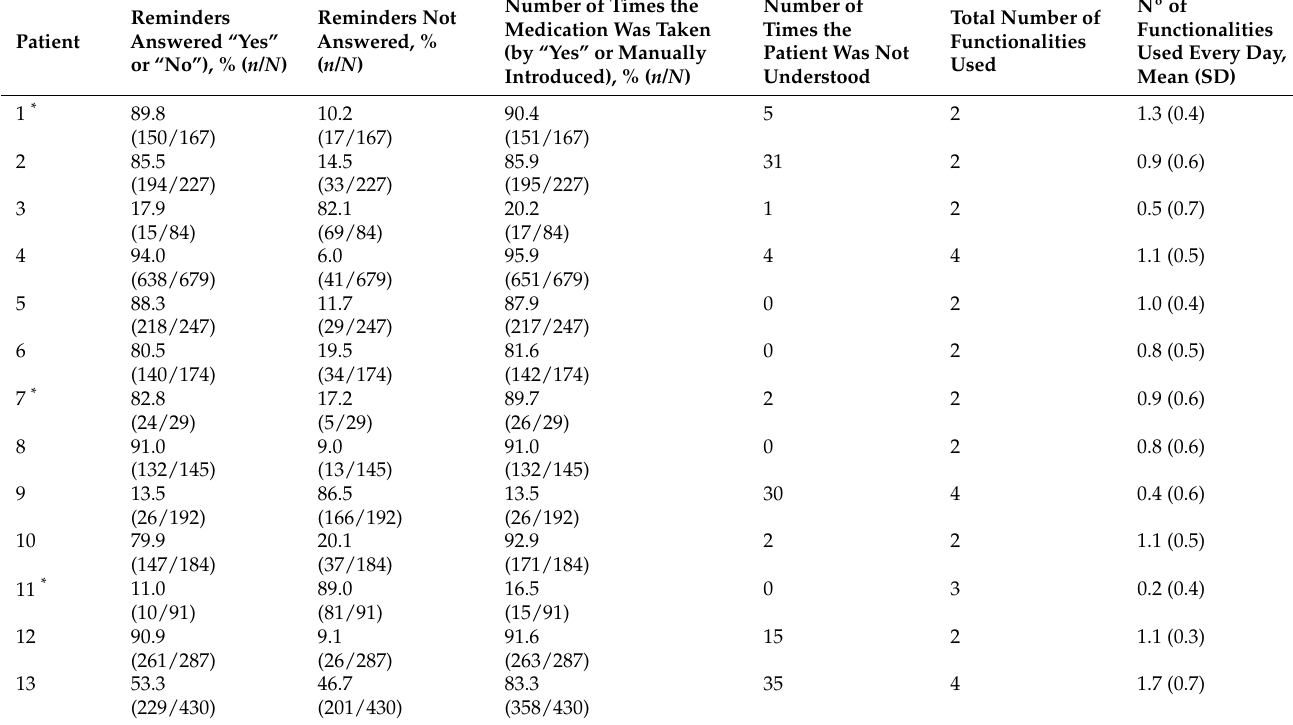
Table 5. Results of reminders activity and interaction